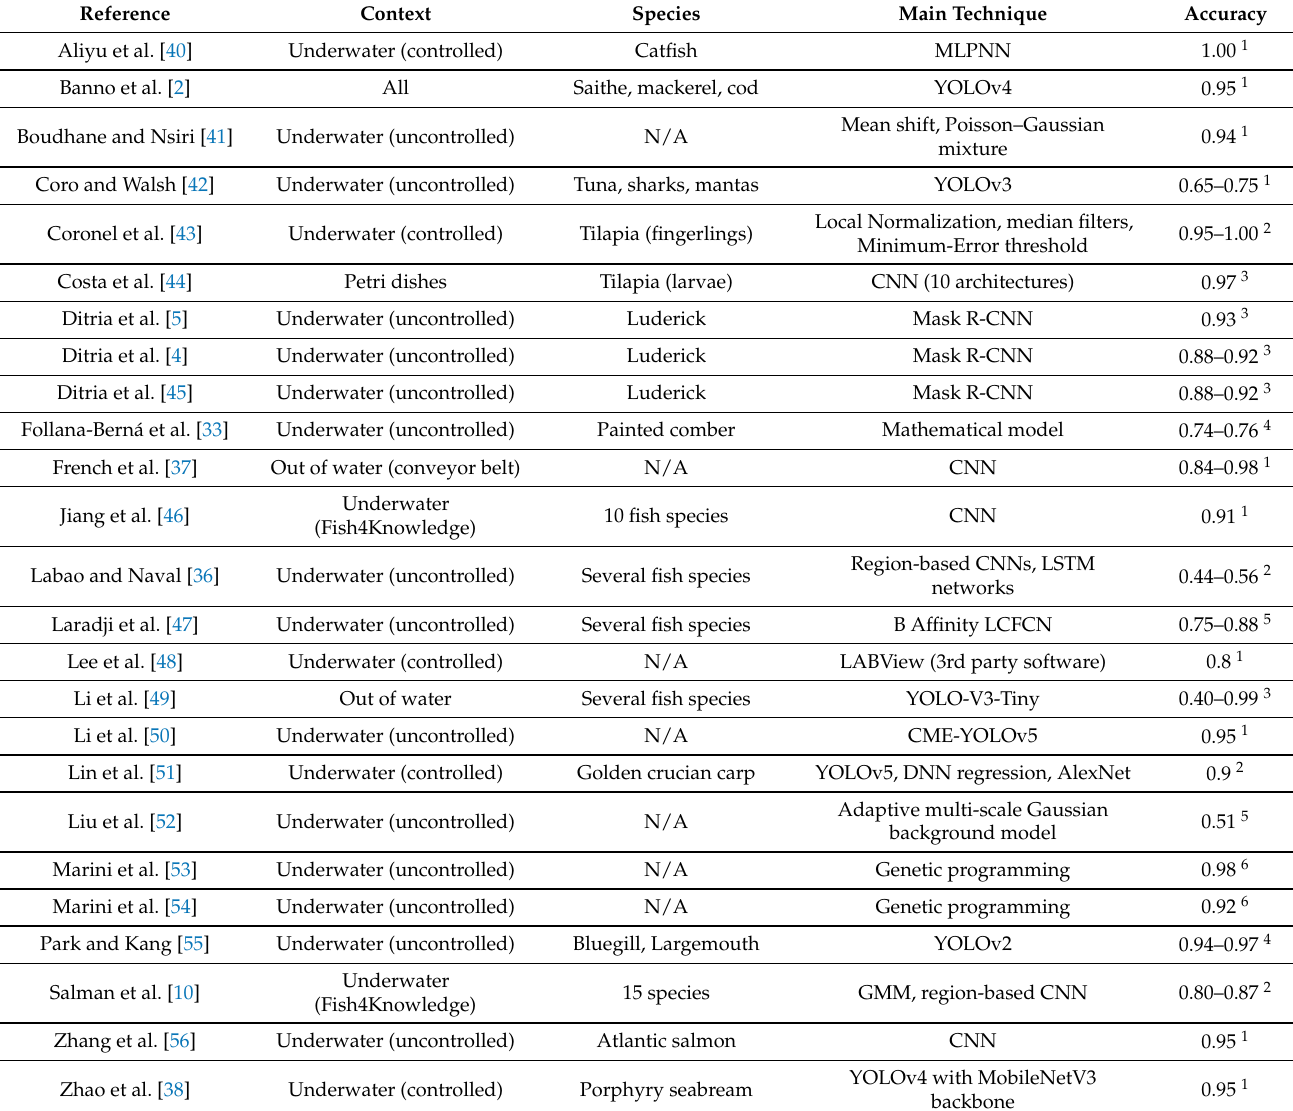
Table 3. List of articles dealing with detecting and counting